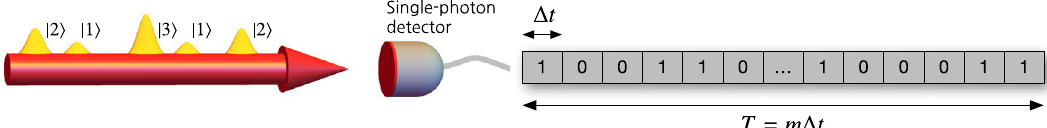
Figure 3. Time-integrated on/off detection is performed at each mode by a single photon counting module (SPCM) for an exposure time T that consists of m intervals of (cid:31) t , i.e., T outcomes are obtained for time T , where the outcomes ‘0’ and ‘1’ denote the absence and the presence of photons,